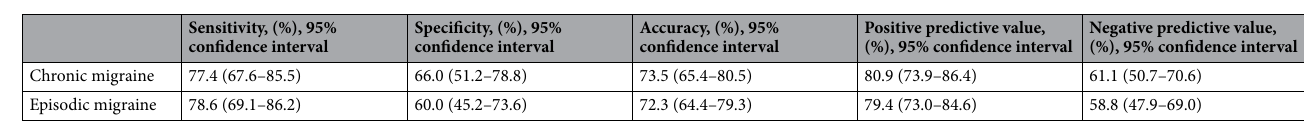
Table 2. The sensitivity, specificity, accuracy, positive-predictive value, and negative-predictive value for episodic and chronic migraine based on the cut-off values for plasma glutamate